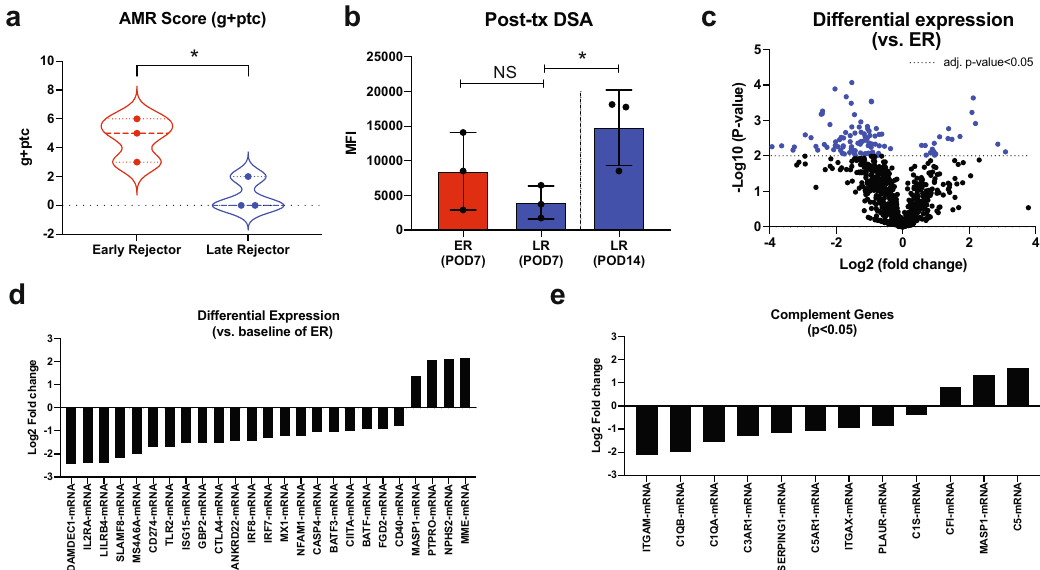
Fig. 4 Downregulation of complement system related genes promoted long-term graft survival in Cp40-treated animals. a Antibody-mediated rejection (AMR) score calculated based on Banff grading (g + ptc) from ER ( n = 3) and LR ( n = 3) groups. AMR score was signi fi cantly elevated in ER group ( p = 0.0224). Mean ± S.D. is presented. (* p < 0.05 using two-tailed unpaired t test). b Early post-transplant DSA in ER at day 7 ( n = 3), LR at day 7 ( n = 3), and LR at day 14 ( n = 3). DSA was signi fi cantly increased in LR at day 14 compared to LR at day 7 ( p = 0.0365). Data are presented as mean ± S.D. (NS using two-tailed parametric unpaired t test and * p < 0.05 using two-tailed parameteric paired t test). c Global gene downregulation in Cp40-treated animals with prolonged graft survival in LR compared to ER. (The calculated p -values are adjusted using the Benjamini – Yekutieli method after the regression analysis using a simpli fi ed negative binominal model or a log-linear model). d Top 25 genes signi fi cantly changed in LR compared to ER. e Changes in complement system related genes in LR compared to ER. N number indicates biologically independent animals; NS indicates no statistical signi fi